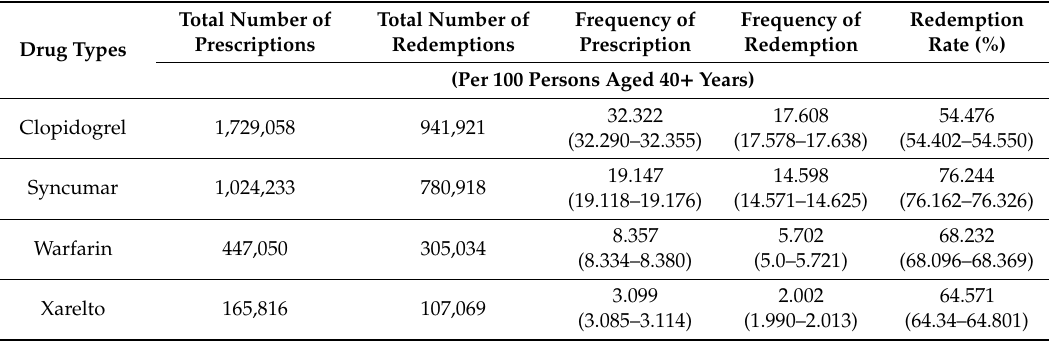
Table 2. Anticoagulant utilization (prescription, redemption, and redemption rate) by drug types, Hungary,